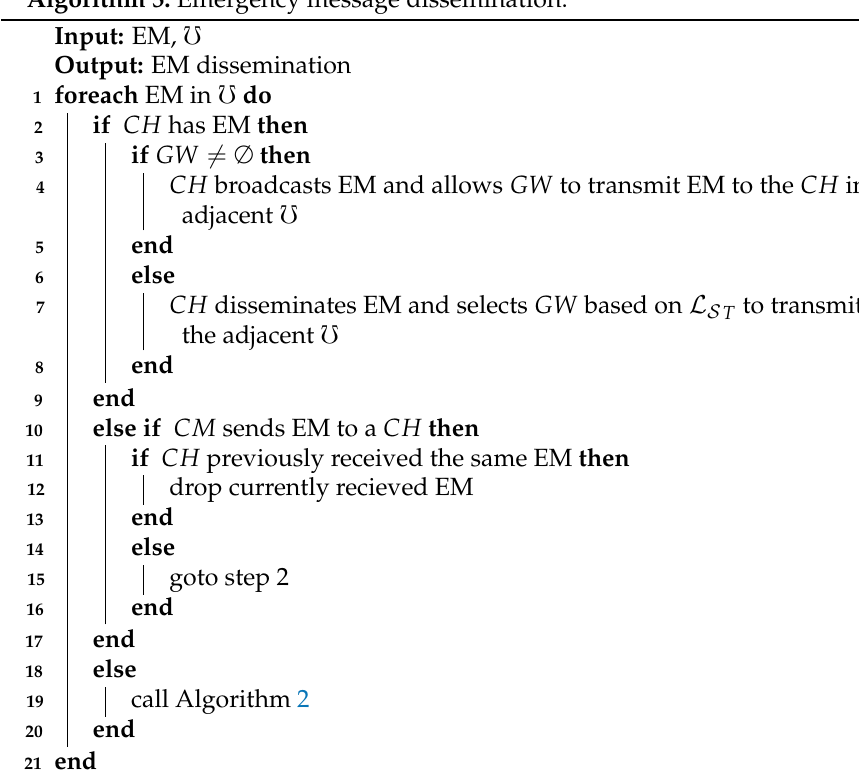
Algorithm 5: Emergency message dissemination.